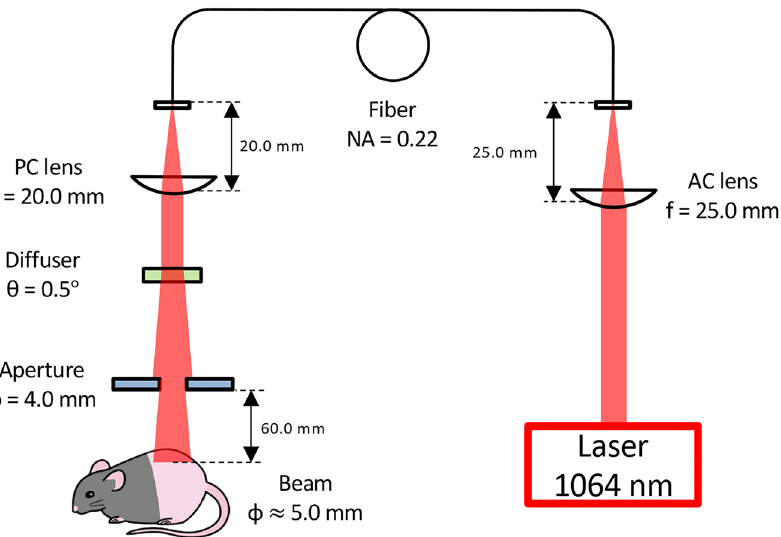
Figure1: Aschematicofthelaserirradiationsystem.Acontinuouswave(CW)Nd:YAGlaser( λ =1064nm)wasusedasasourceofnear-infrared (NIR) light. The 1064 nm beam was directed to multimode optic fi ber (Core: 200 µm, NA: 0.22) by an achromatic lens. To disperse the beam mode and obtain a homogenized fl at-top intensity distribution, a holographic diffuser was used in the optical path. The diverging laser was collimated by a plano-convex lens. The beam diameter was set to be 5 mm by adjusting the diameter of an aperture and the distance between the iris and an animal. NA: numerical aperture, AC: achromatic, PC: